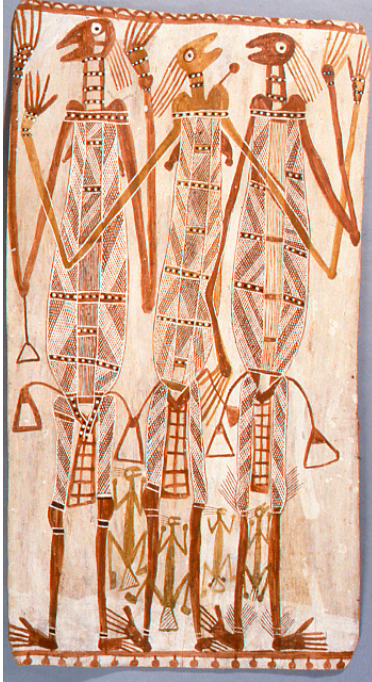
Figure 8. Yirawala, Mimi Spirits , c. 1970, 90 cm × 48 cm, Ochre on bark, image courtesy the South Australian Museum, Adelaide. © The estate of the artist licensed by Aboriginal Artists Agency Ltd.